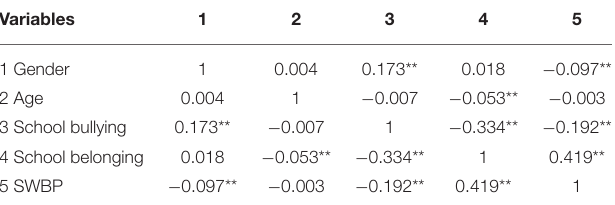
TABLE 2 | Correlation coefficient between related variables ( n = 11,631).